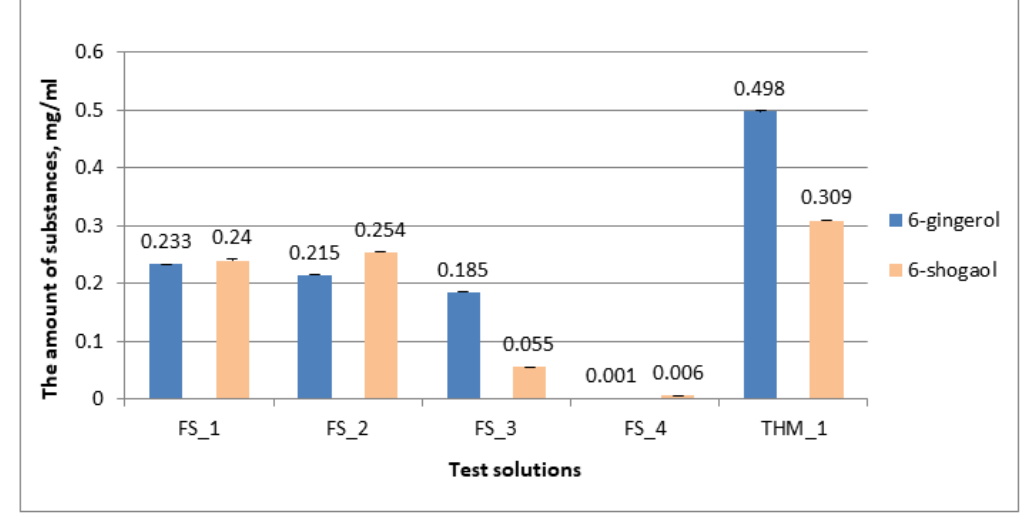
Fig. 7. 6-gingerol and 6-shogaol composition of various test